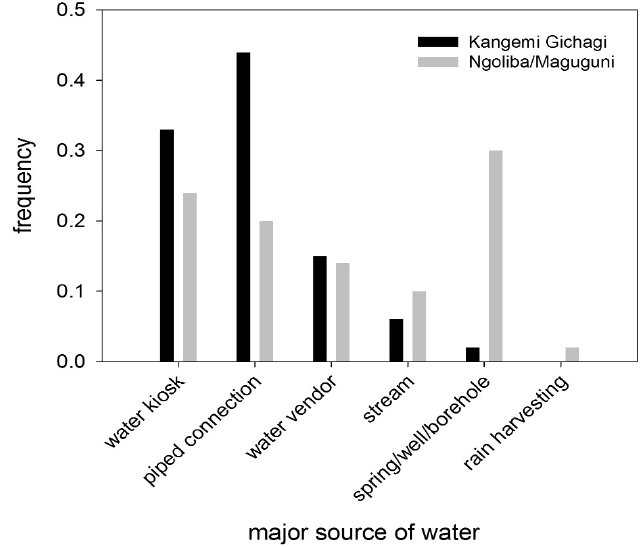
Figure 4. Main source of water in urban Kangemi Gichagi ( N = 48), and rural Ngoliba/Maguguni ( N =